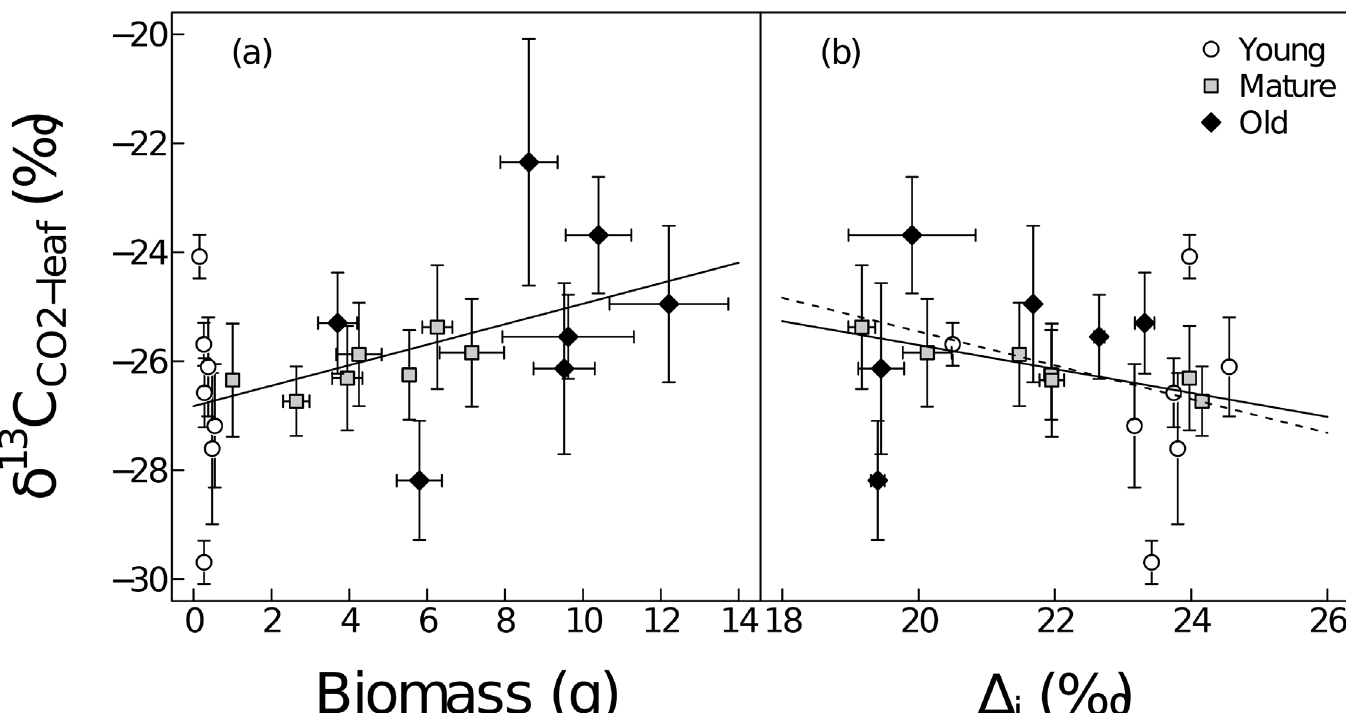
Fig 2. Response of δ 13 C values of leaf-respired CO 2 ( δ 13 C CO2-leaf ) to leaf biomass (a) and to Δ i (b) at three ontogenetic stages: young foliage (young, white circles), maximum growth rate (mature, grey squares) and beginning of senescence (old, black diamonds). Each point represents the average value (n = 6) for a given plant species at a given ontogenetic stage. Regressions are based on average values and given across all species and ontogenetic stages in (a) (y = 0.19x-26.82, R 2 = 0.23, p = 0.028) and for all ontogenetic stages (dashed line, y = -0.31x-19.26, R 2 = 0.25, p = 0.021) as well as mature stage only in (b) (y = -0.21x-21.31, R 2 = 0.83, p = 0.0045). Error bars indicate ±